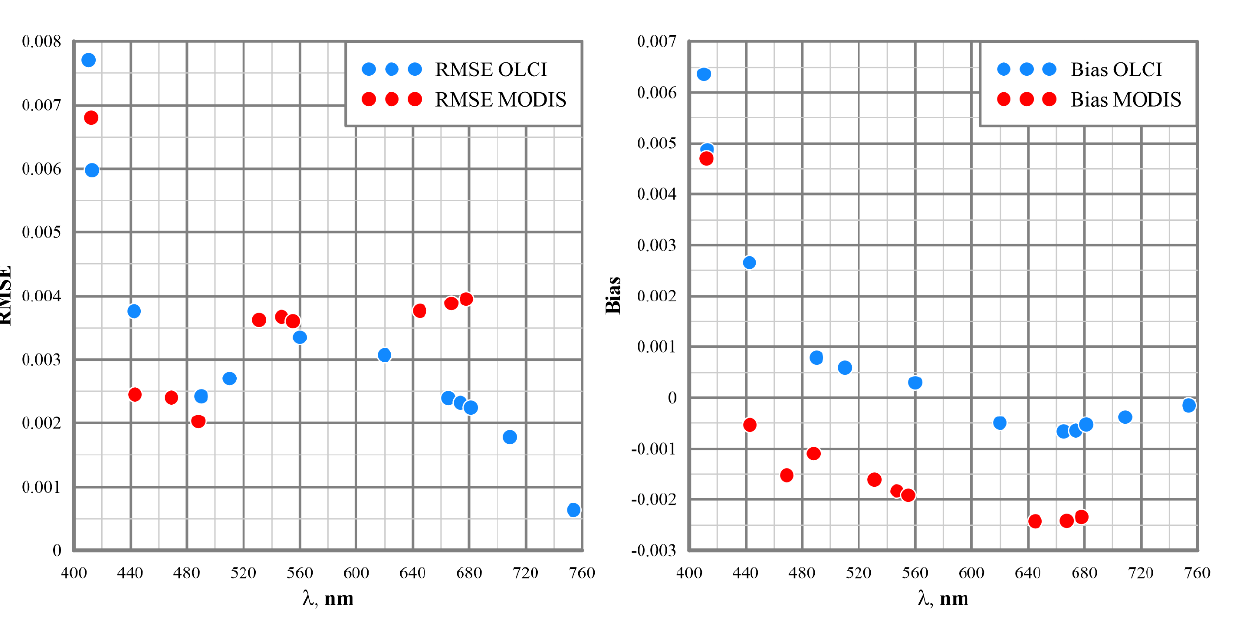
Figure 6. RMSE and bias of MODIS and OLCI data of remote sensing reflectance.